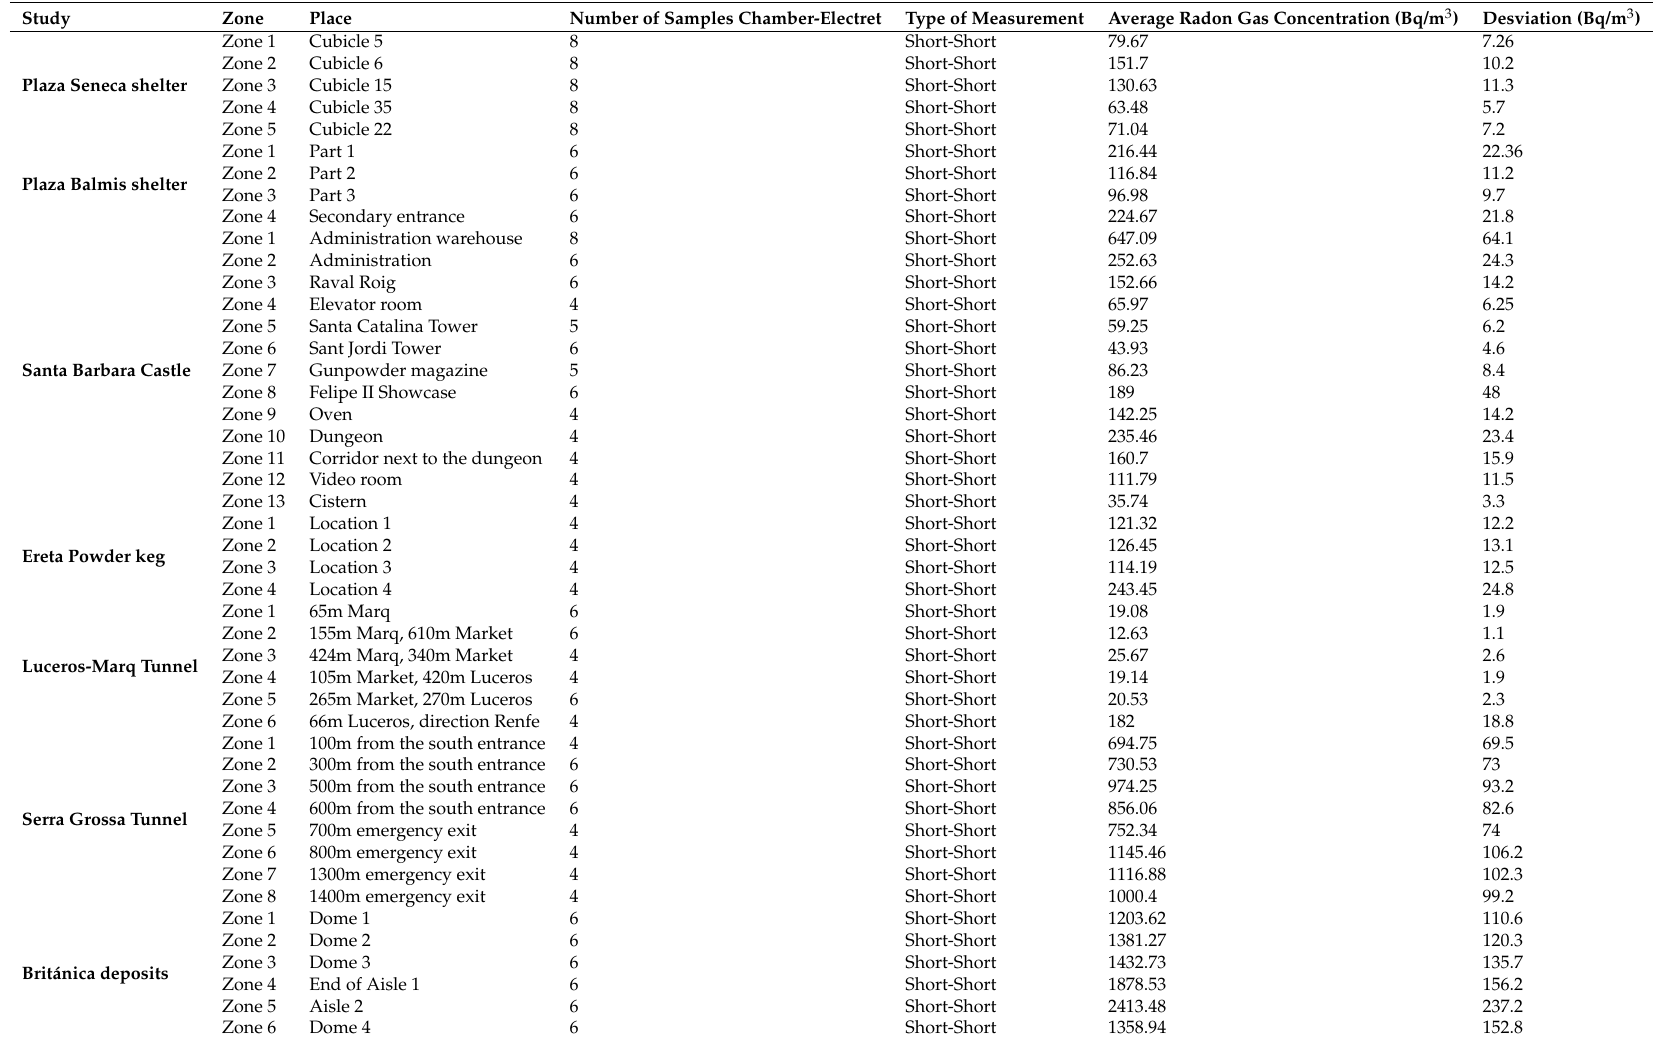
Table 1. Results obtained for the different measurements that were